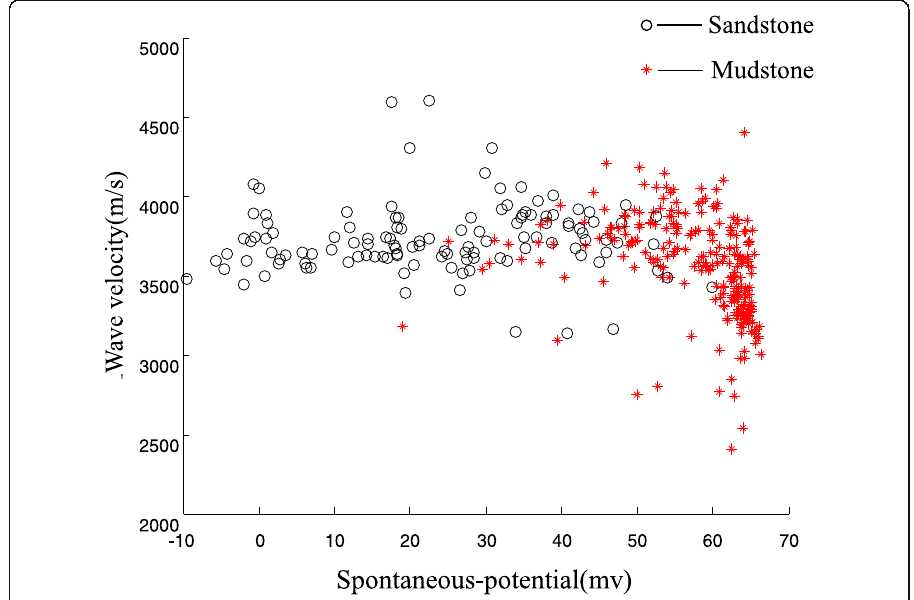
Fig. 2 Wave velocity vs . SP of sandstone and mudstone in the target